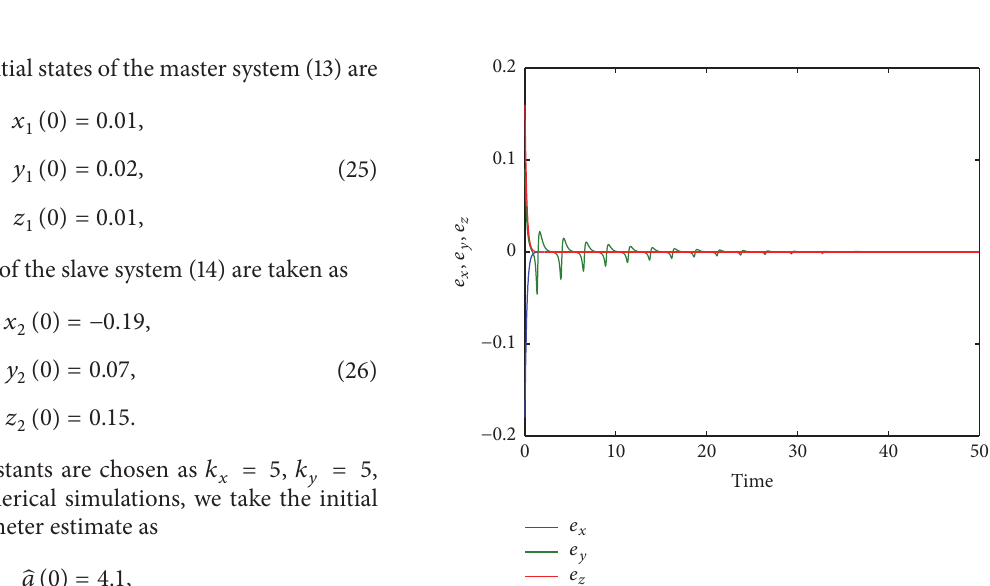
Figure 9: Antisynchronization of the slave system and the master system (a) 𝑥 1 , 𝑥 2 state variables, (b) 𝑦 1 , 𝑦 2 state variables, and (c) 𝑧 1 , 𝑧 2 state variables (state variables of the slave system (red dashed lines), state variables of the master system (blue solid lines)).